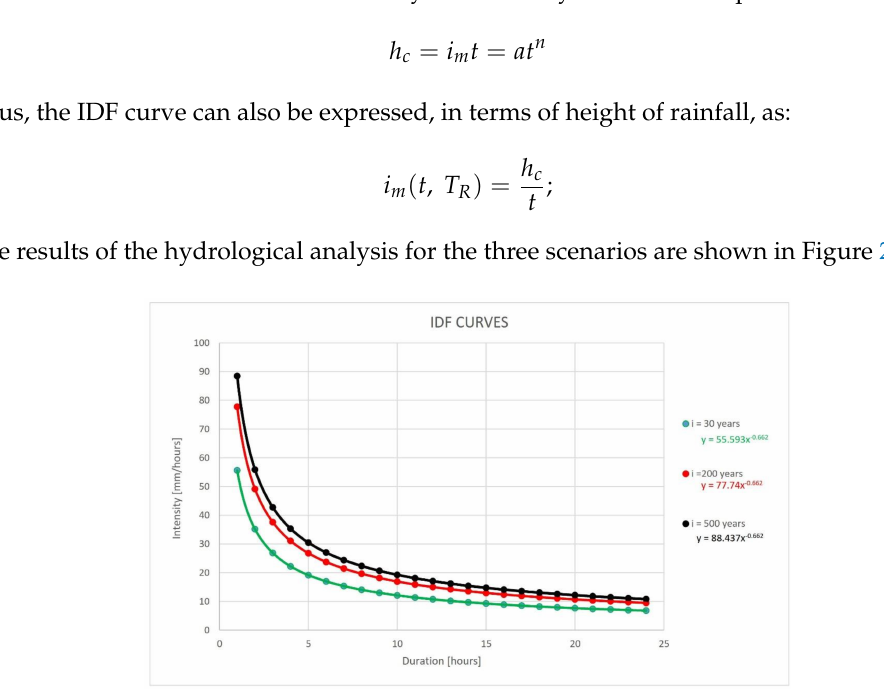
Figure 2. Intensity-Duration-Frequency (IDF) curves for a return period of 30, 200, and 500